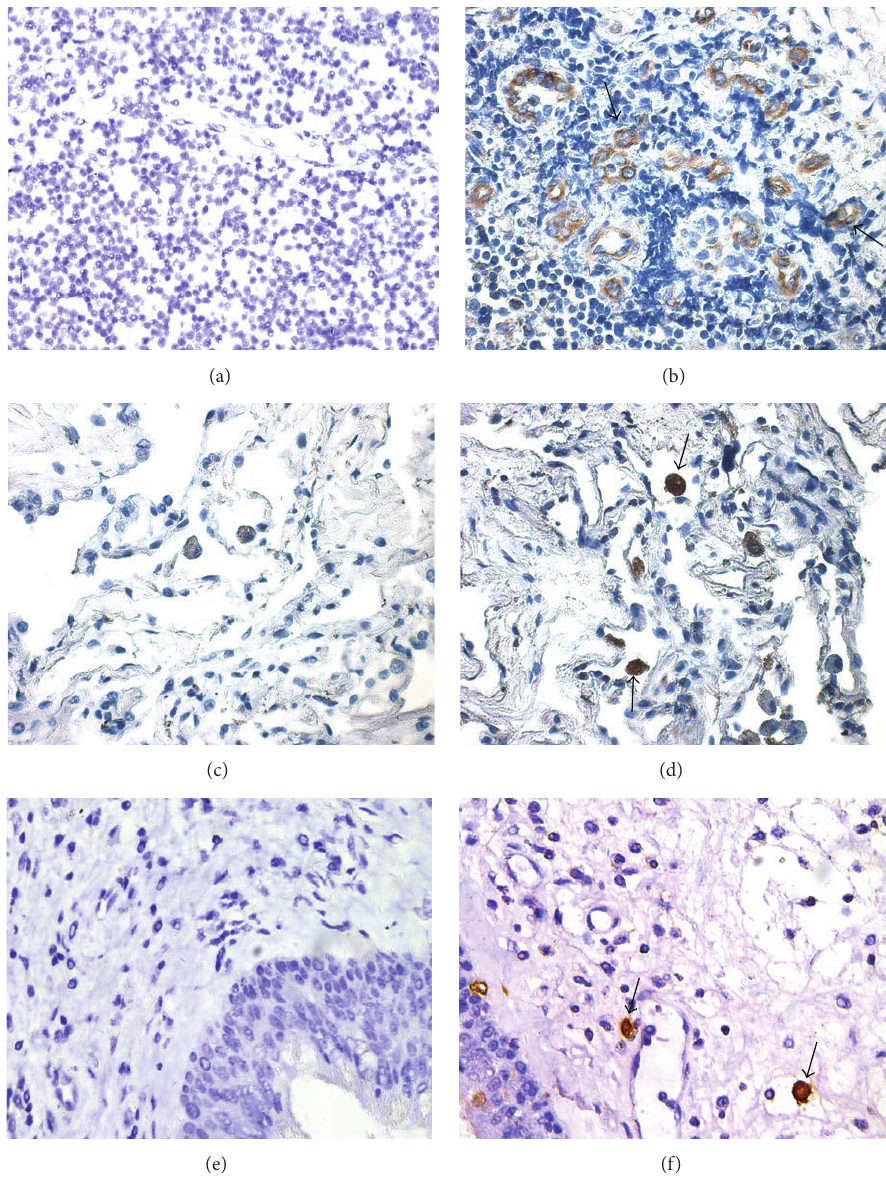
Figure 3: Immunohistochemical staining of IFN- 𝜆 2 in human tonsil, lung, and nasal polyps tissues. Biotinylated anti-human IFN- 𝜆 2 antibody was employed to identify IFN- 𝜆 2+ cells in the sections from tonsil (b), lung (d), and nasal polyps (f), respectively. Mouse IgG- peroxidase labeled anti-mouse IgG was used as negative control for tonsil (a), lung (c), and nasal polyps (e). Arrows indicate positively stained cells. All sections were counterstained with Mayer’s haematoxylin. Magnification was × 400.